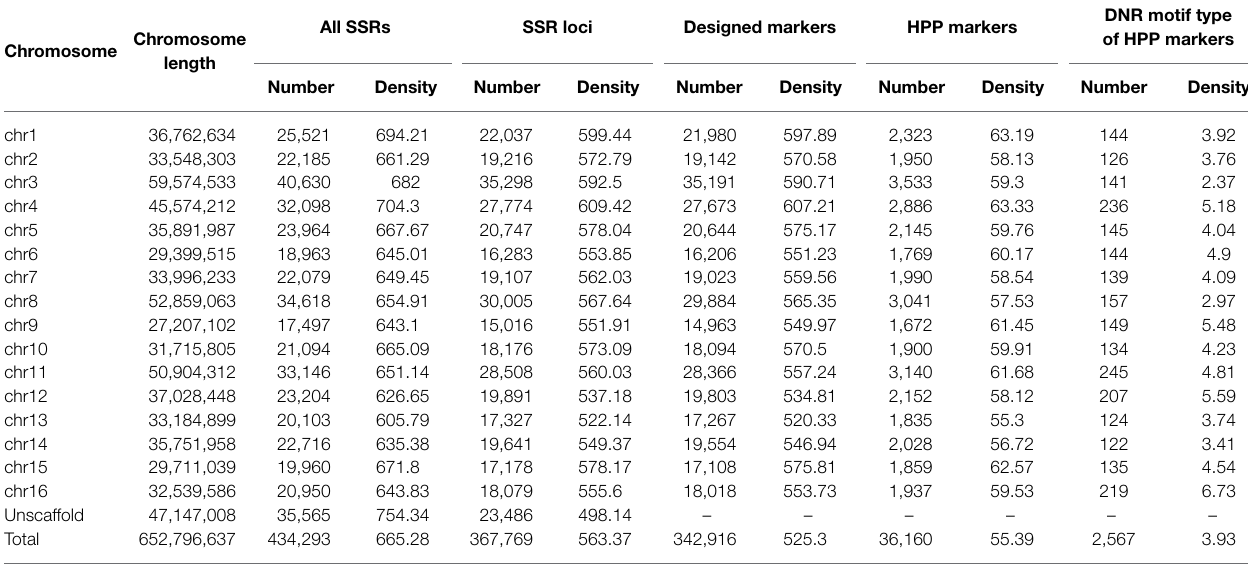
TABLE 1 | Statistical analysis of SSRs and markers on each chromosome of Akebia trifoliata . All SSRs SSR loci Designed Chromosome Chromosome length